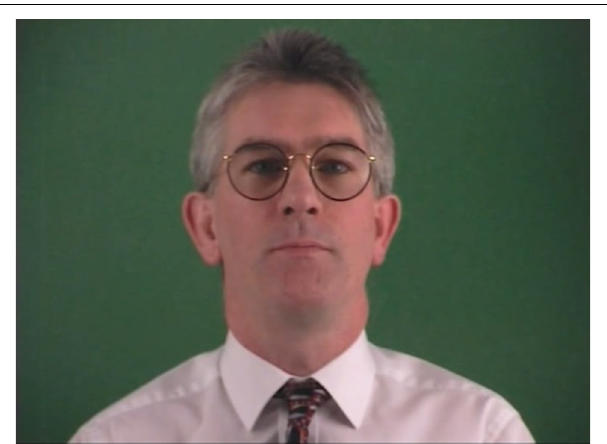
FIGURE 1 | Frame taken from a visual speech stimulus. This picture shows the speaker participants watched during the visual speech trials. No auditory stimulation was presented during these trials as the speaker was muted. The subjects were instructed to focus their attention on the speaker’s mouth (hence were lip-reading). When visual stimuli (or reward stars) were not displayed, a plain dark green background matching the dark green background in this picture was shown with a small fixation cross located at the approximate position of the speaker’s